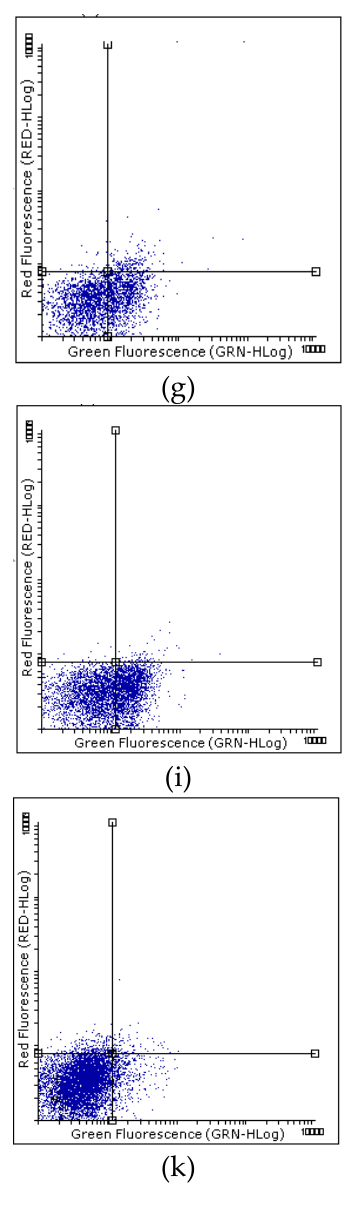
Figure 8. Flow cytometry cytograms of cell viability (intact cells (Q1-LL), early apoptosis cells (Q1-LR), late apoptosis cells (Q1-UR), necrotic cells (Q1-UL)) ( a ) and ( b ) C. albicans from polyurethane foam. ( c ) C. subhashii from polyurethane foam. ( d ) C. albicans from Bialecki ring (25 × 25). ( e ) C. subhashii from Bialecki ring (25 × 25). ( f ) C. albicans from Pall ring. ( g ) C. subhashii from Pall ring. ( h ) C. albicans from Bialecki ring (50 × 50). ( i ) C. subhashii from Bialecki ring (50 × 50). ( j ) C. albicans —control with cells not immobilized. ( k ) C. subhashii —control with cells not immobilized.